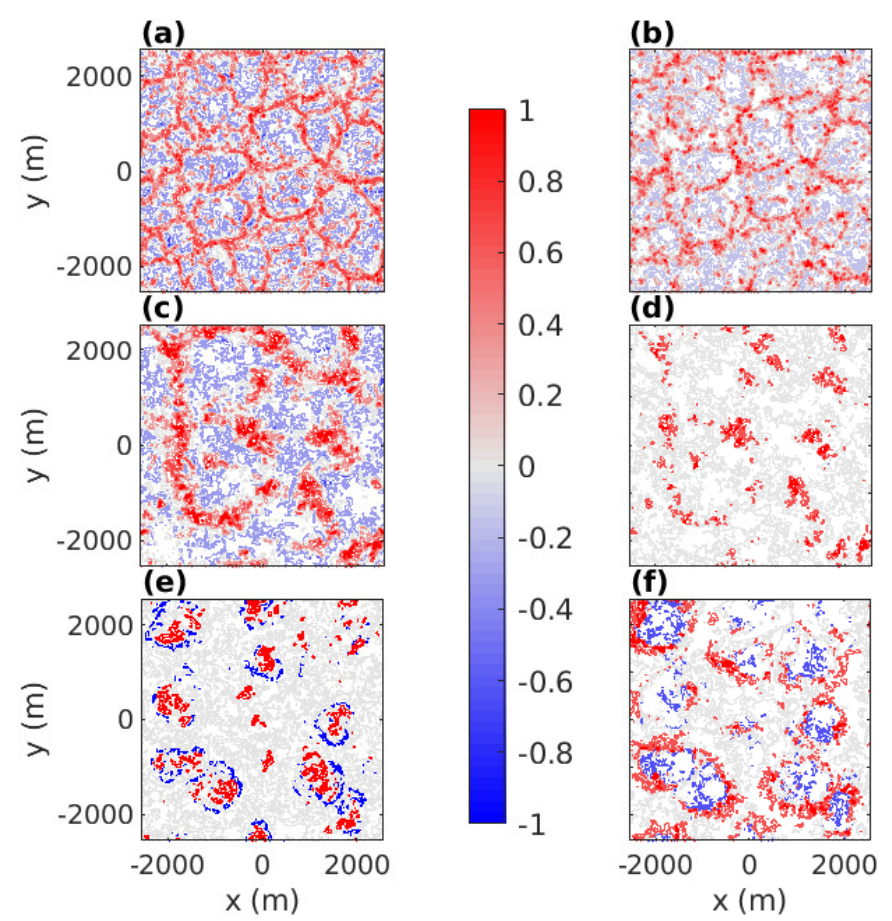
Figure 8. Horizontal cross-sections of ( a , c , e ) vertical velocity and ( b , d , f ) perturbation potential temperatures θ (cid:48) from the 10 m grid length “truth run” of CBL1, at heights of ( a , b ) 192 m/0.17 z i , ( c , d ) 512 m/0.45 z i and ( e , f ) 1024 m / 0.9 z i . The range of values that provides a normalization factor for the colour bar in ( a ) and ( c ) is − 1.5 to 1.5 ms − 1 , in ( e ) is − 0.08 to 0.08 ms − 1 , while that in ( b , d , f ) is − 0.08 to 0.08